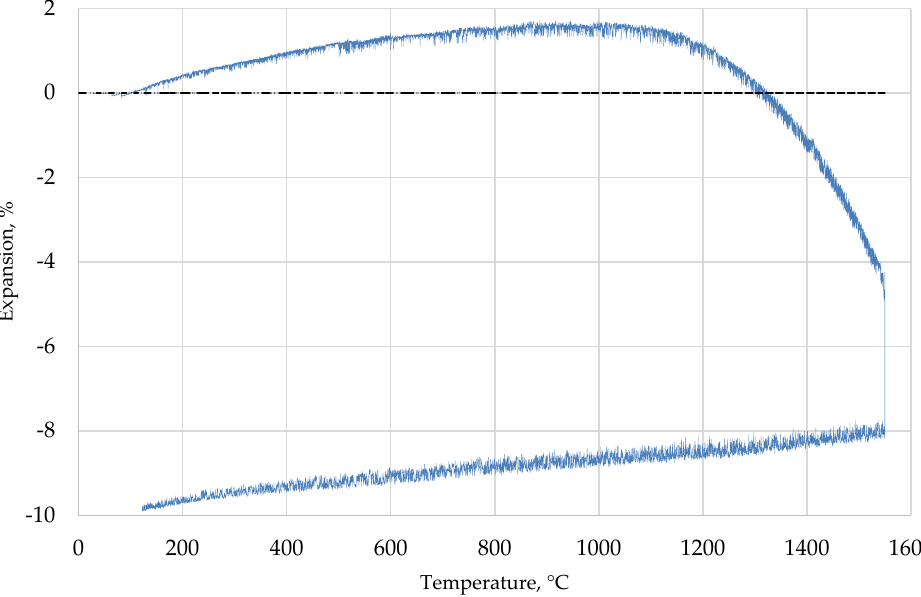
Figure A4. Variation of apparent viscosity of 70 wt.% suspensions with three different composition of waste alumina powder as a function of increasing and decreasing shear rate.